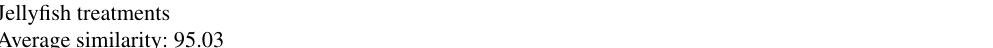
Table C1. SIMPER analysis of main predicted functions based on KEGG orthologs. SIMPER analysis indicating the main predicted functions characterizing the jellyfish and control communities ( N = 3). Av. abund indi- cates average abundance, av. sim indicates average similarity, sim/SD indicates similarity standard deviation, contrib. % indicates percent contribution, and cum. % indicates cumulative contribution.